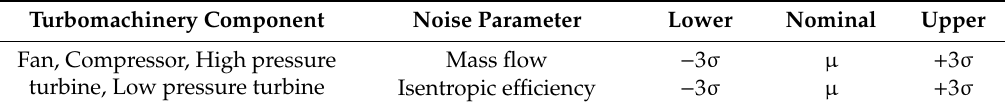
Table 2. Component uncertain performance parameter range